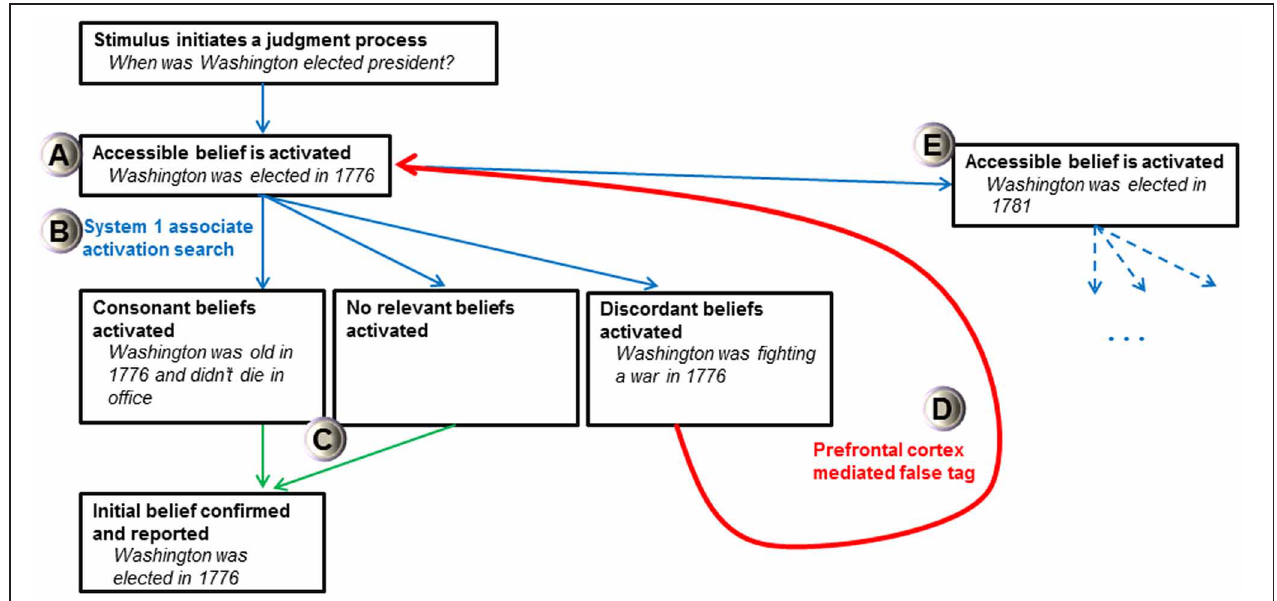
FIGURE 3 | Schematic of False Tagging Theory’s anchor-and-adjustment process. Bold text represents the stage and italicized text is an example of a self-generated anchor process (Epley and Gilovich, 2001). Blue arrows represent System 1 association activation processes, green arrows represent